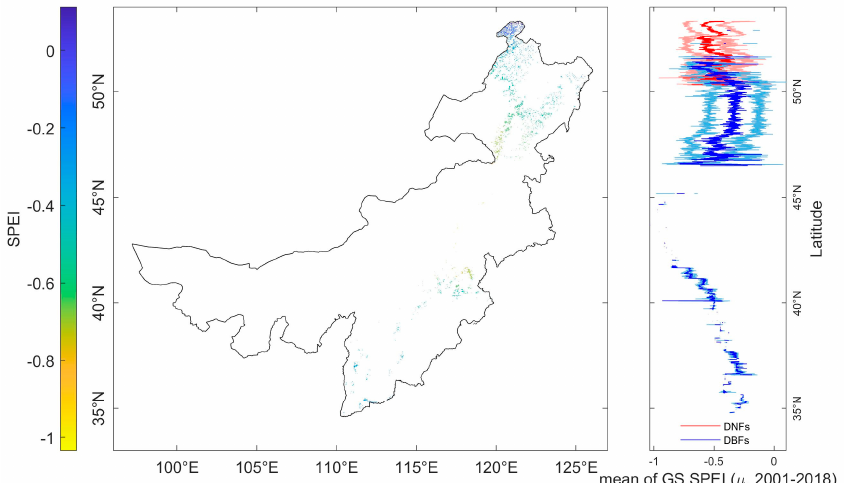
Figure A2. Spatial distribution of mean SPEI12 during 2001–2018. The panels on the left are the spatial distributions of the mean SPEI12 calculated from each pixel, while the panels on the right are the mean ± std of the latitudinal values of the DNFs (red lines) and DBFs (blue lines). Table A1. Partial correlation coefficients of SPEI SD , temperature and radiation with TS EVI and TS GPP . In this study, the p values of all results were less than 0.001.